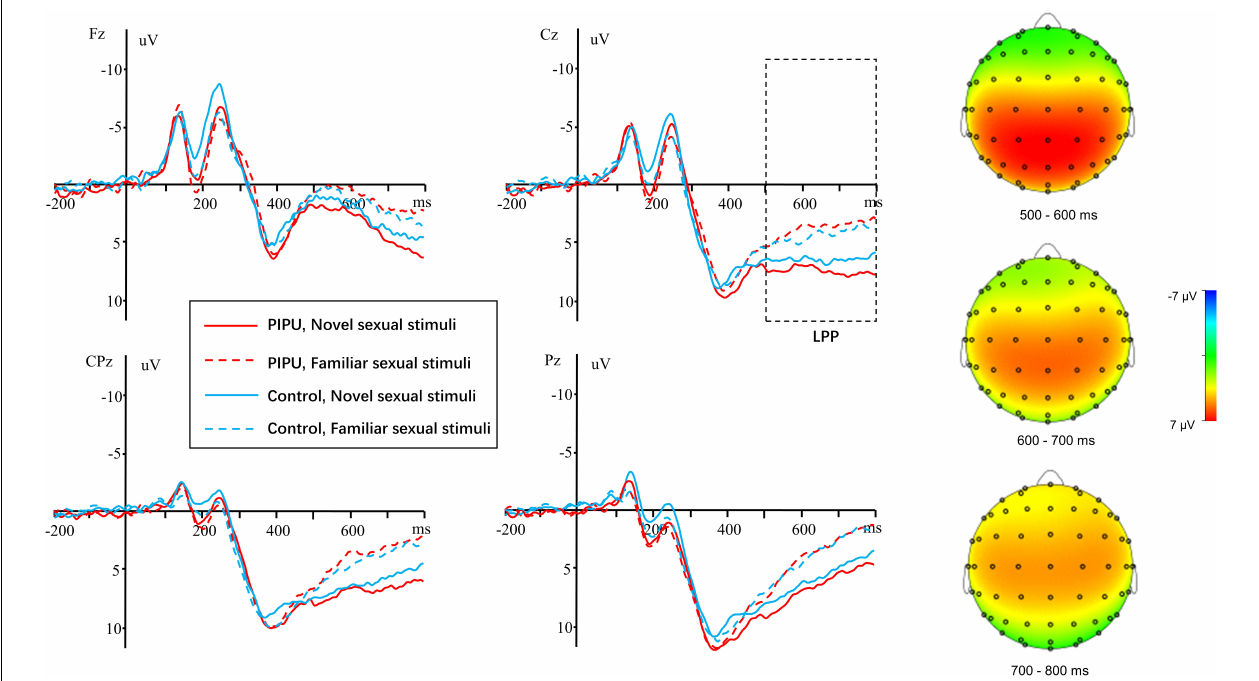
FIGURE 1 | The grand average and scalp topography of LPP component for the individuals with high tendencies toward PIPU vs. low tendencies under the novel and familiar sexual stimuli for electrodes sites at Fz, Cz, CPz, and Pz.